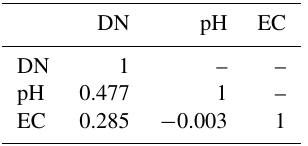
Figure 5. Change detection map of the Bathinda district. Table 6. Correlation ( r ) between the digital number of band 5 and soil physico-chemical